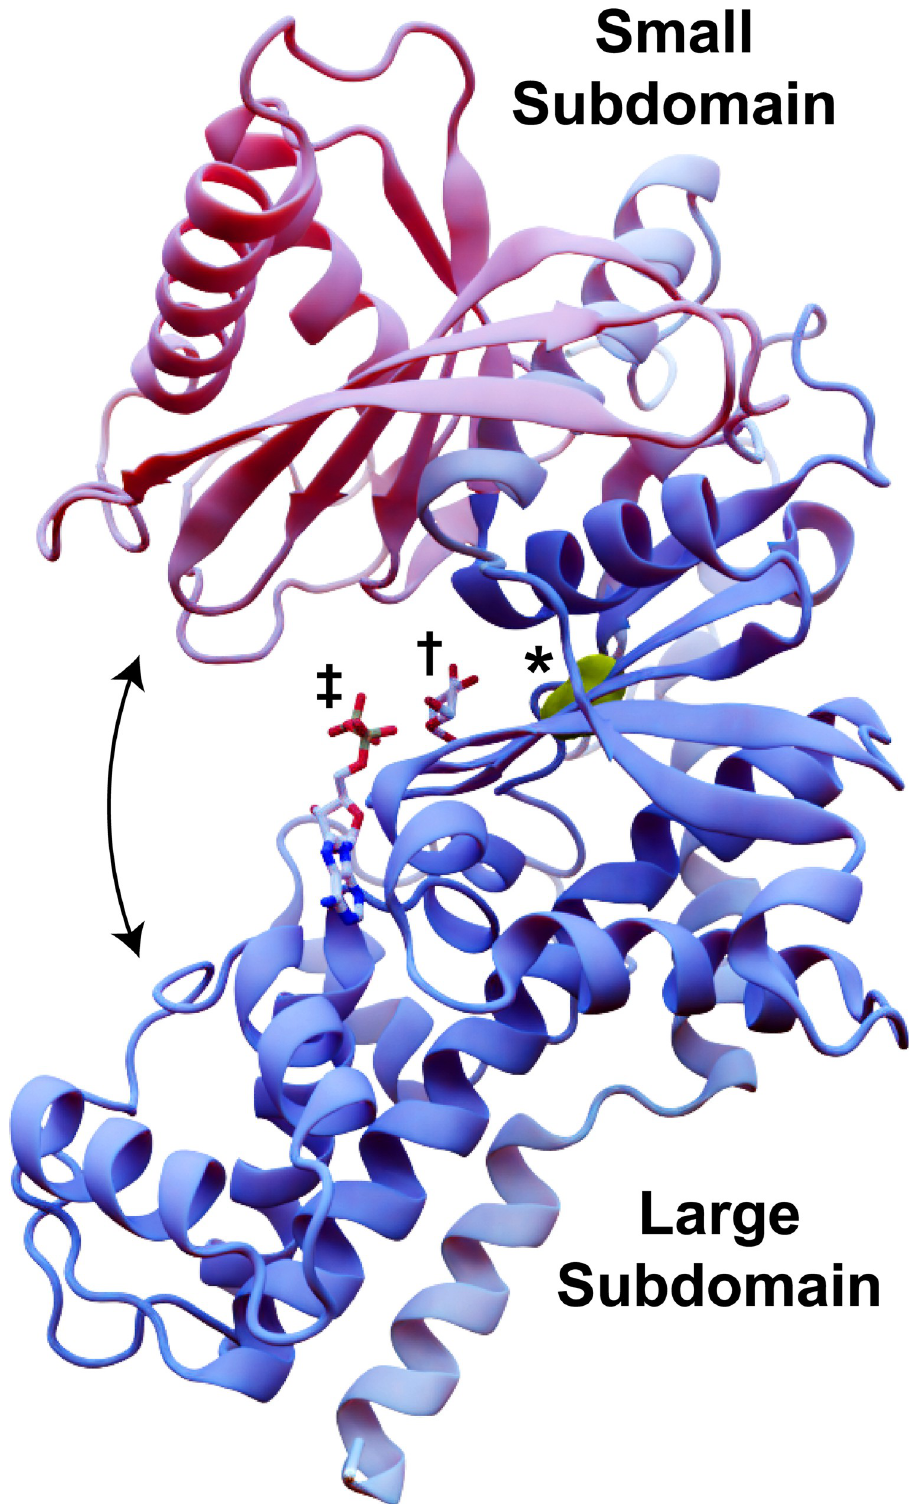
Fig 1. Sc Hxk2 structure and global dynamics. The mostly helical large subdomain and the α / β small subdomain are shown in blue and pink, respectively (PDB 1IG8). The curved arrows indicate the approximate motion of domain closure. The location of residue 238 is shown in yellow and marked with an asterisk. To indicate the location of